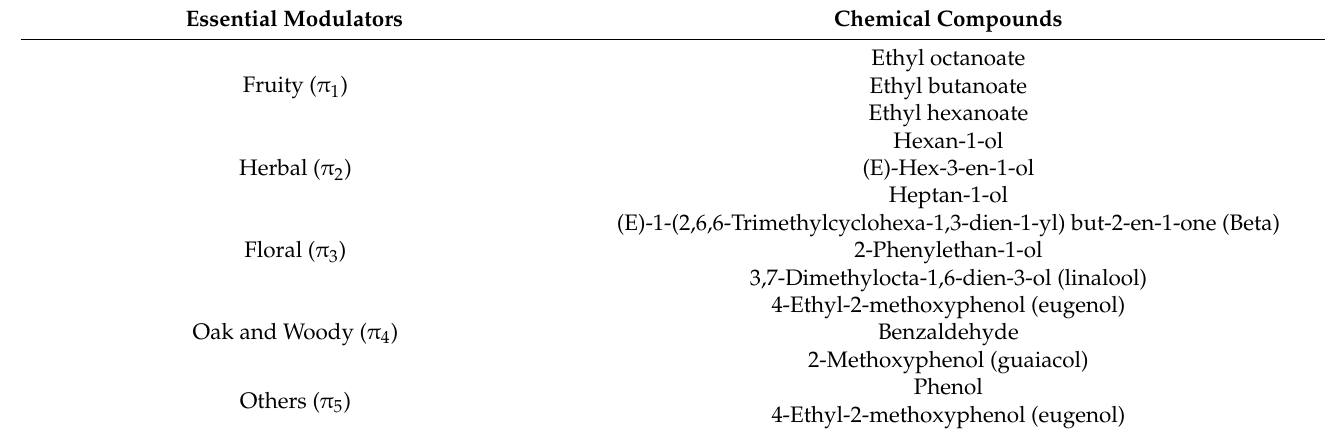
Table 3. List of selected chemical compounds to build up essential